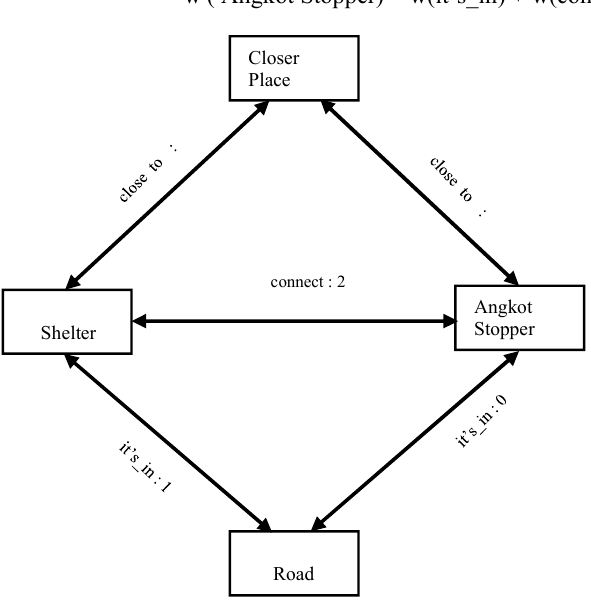
Fig. 2 O-ERD for multimodal